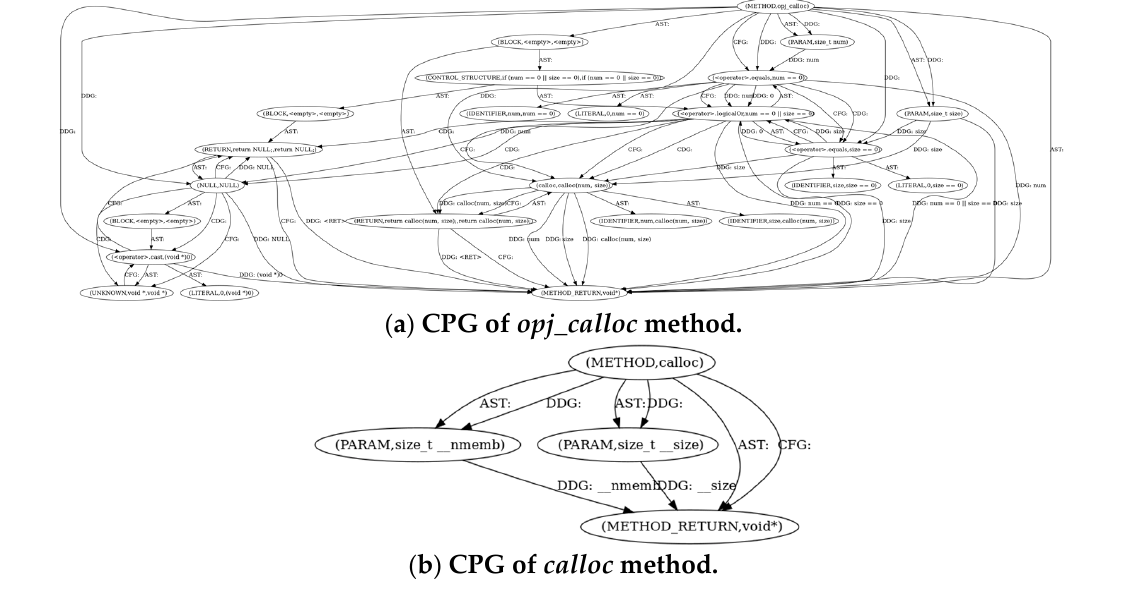
Figure 3. CPG of OpenJPEG v2.3.0 opj_calloc and calloc methods.